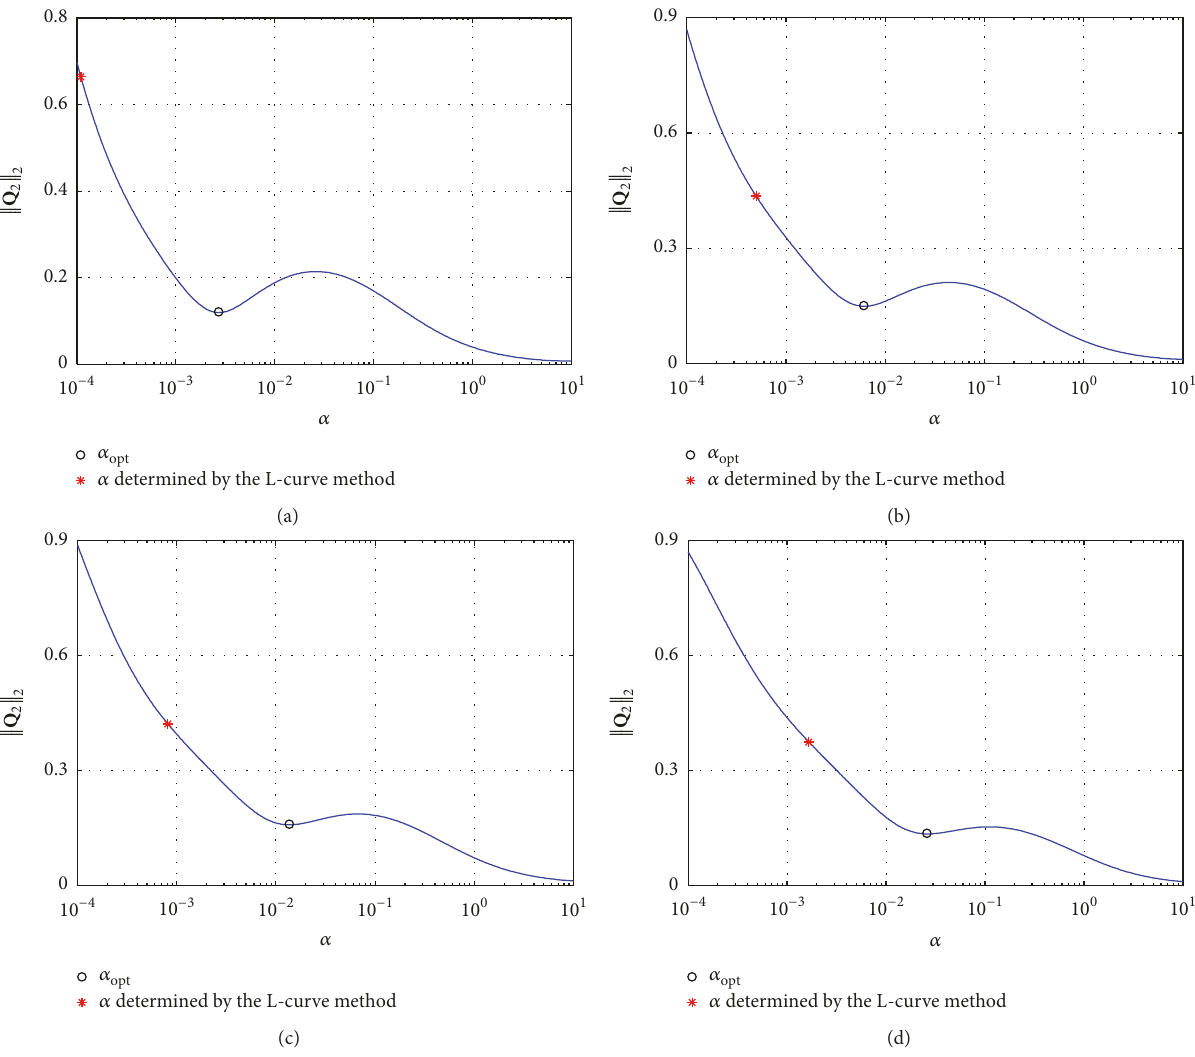
Figure 14: Object function versus the regularization parameter of the pressure reconstruction for the pulsating sphere at (a) 300 Hz, (b) 500 Hz, (c) 700 Hz, and (d) 900 Hz.